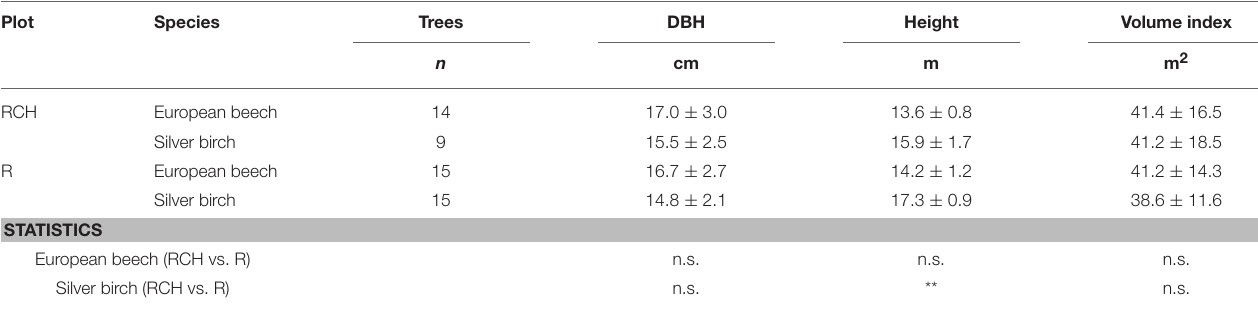
TABLE 5 | Growth performance, expressed as diameter at breast height (DBH), height, and a volume index (diamater 2 x height), of European beech and silver birch trees ( Fagus sylvatica L. and Betula pendula Roth) growth in the relic charcoal hearth (RCH) and in the reference (R) plots. Plot